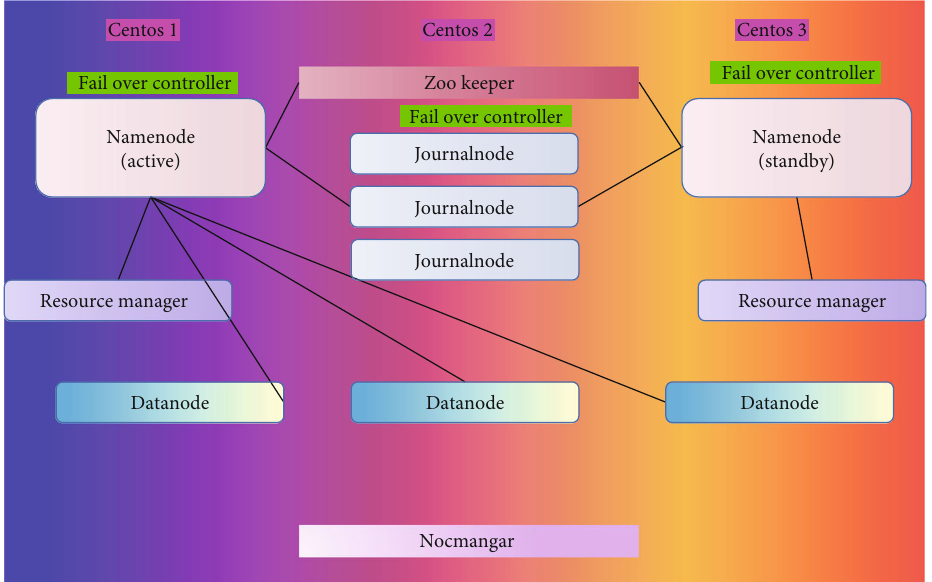
Figure 2: Hadoop cluster architecture diagram.